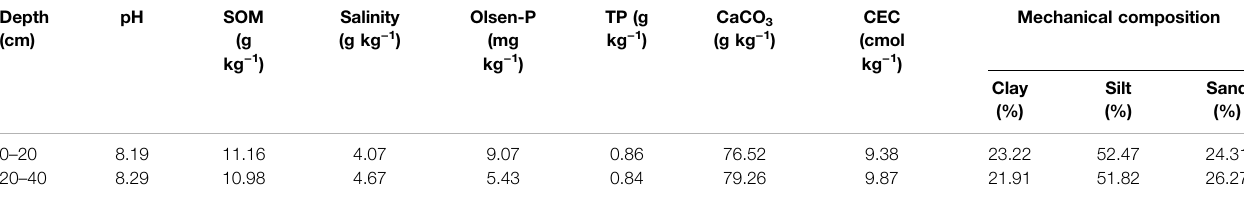
TABLE 1 | Background of soil physicochemical properties. Depth pH SOM (cm)